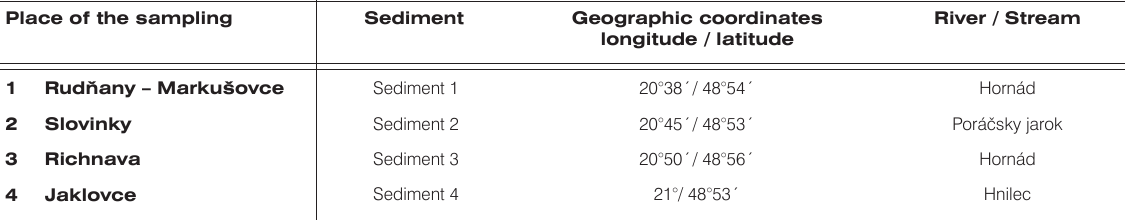
Table 1. Positions of the sampling